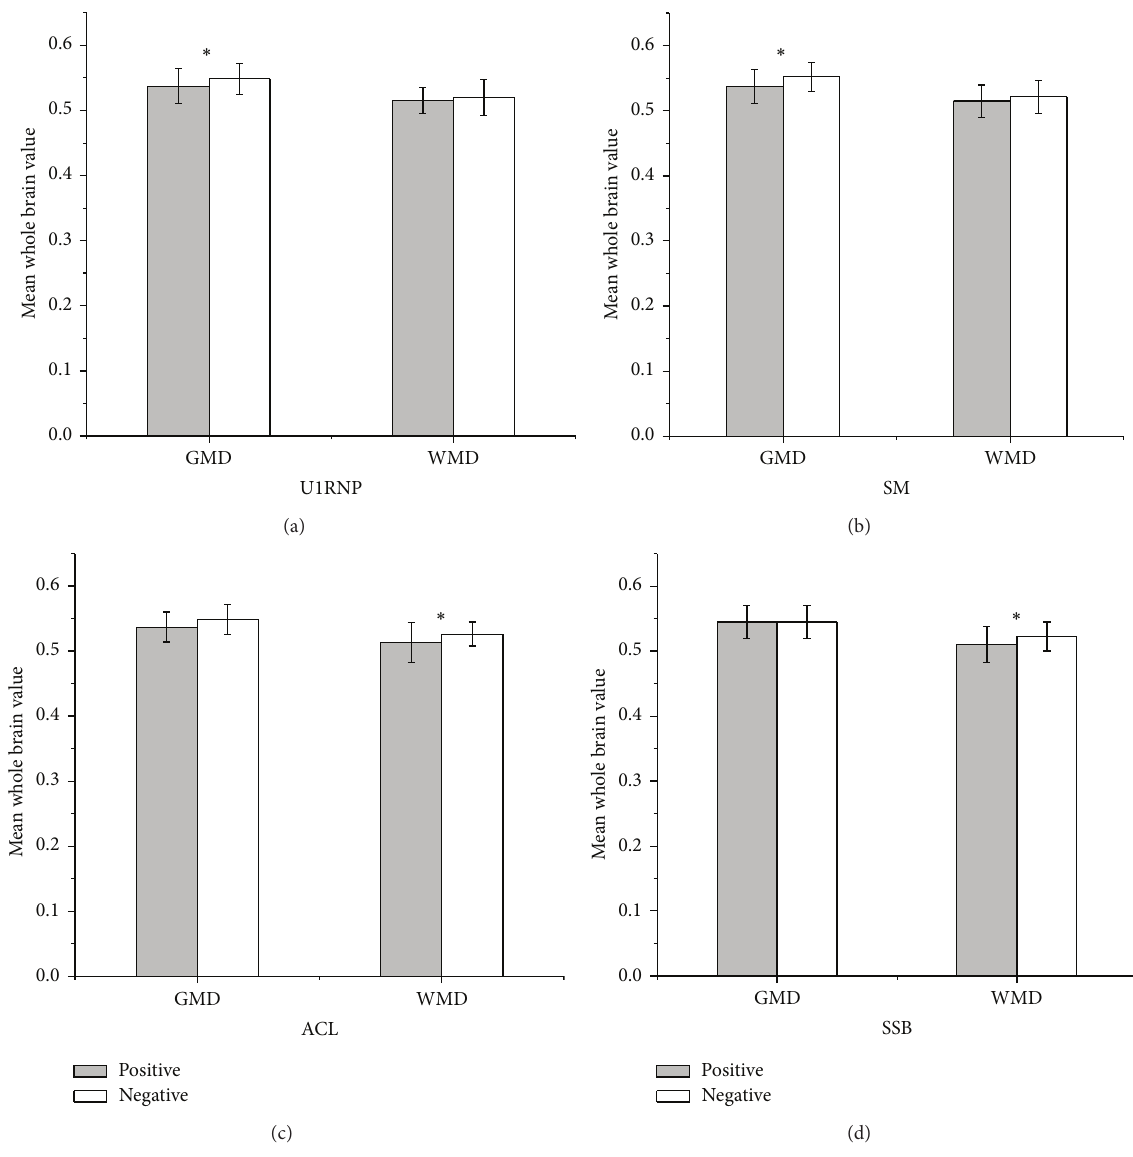
Figure 3: GMD/WMD difference and the relationships with different autoantibodies in SLE patients. The anti-U1RNP and anti-SM antibody- negative patients had higher GMDs than the antibody-positive patients (a, b). The ACL- and anti-SSB/La antibody-negative patients had higher WMDs than the antibody-positive patients (c, d). GMD: mean whole brain grey matter density; WMD: mean whole brain white matter density; ACL: anticardiolipin antibodies; SSB: anti-SSB/La antibodies; U1RNP: anti-U1 RNP antibodies; SM: anti-Sm antibodies. ∗ 𝑃 < 0.05